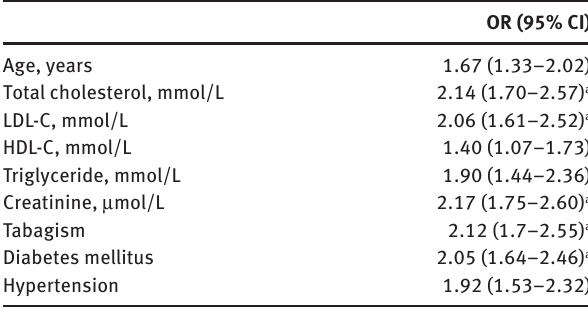
Table 4 Risk of plasma total homocysteine in relation to the number of risk factors in deep venous thrombosis